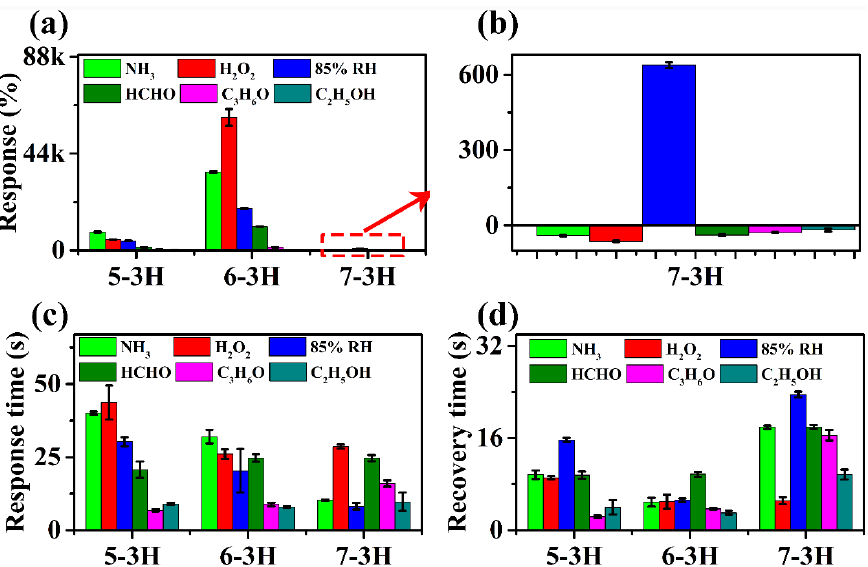
Figure 5. ( a ) Response, the red arrow indicates that ( b ) is a magnified part in the red dotted box in ( a ); ( b ) enlarged part of ( a ); ( c ) response time; ( d ) recovery time of 5 − 3H, 6 − 3H, and 7 − 3H over 3 peaks for 1000 ppm of NH 3 , H 2 O 2 , C 3 H 6 O, CH 2 O, and C 2 H 5 OH vapors and 85% RH at room temperature.